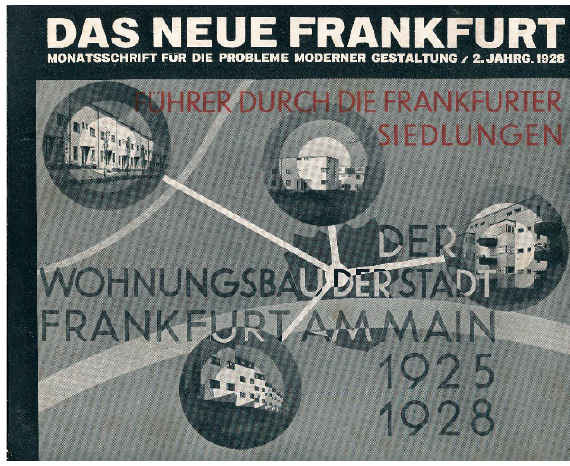
Figure 7. Proposed Satellite City Plan for Frankfurt, adapted from May (1928).